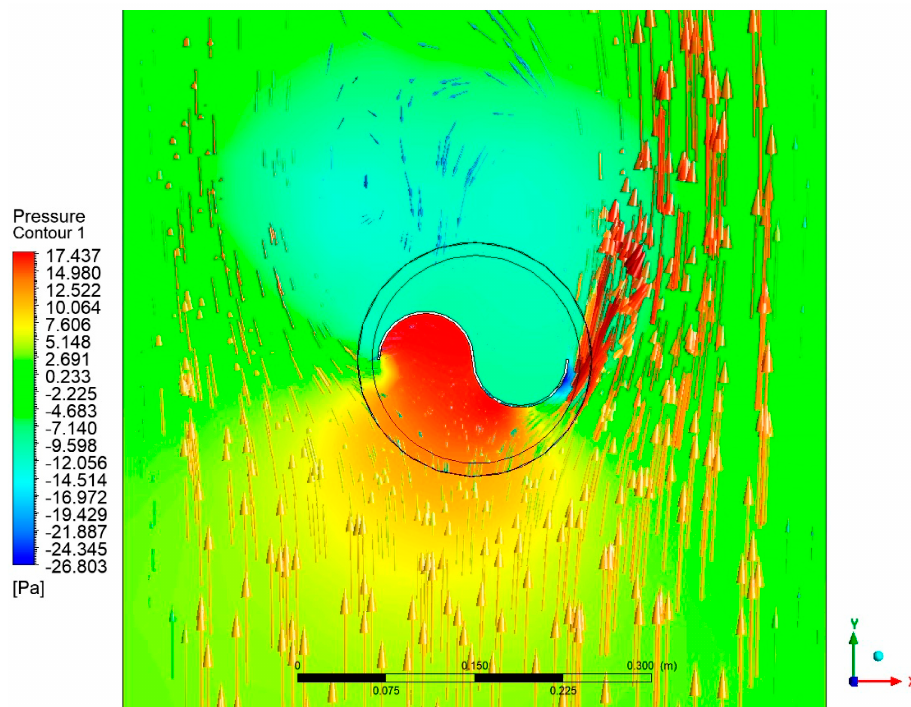
Figure 5. Maximum speed reached by the laminar flow in contact with the Savonius rotor.